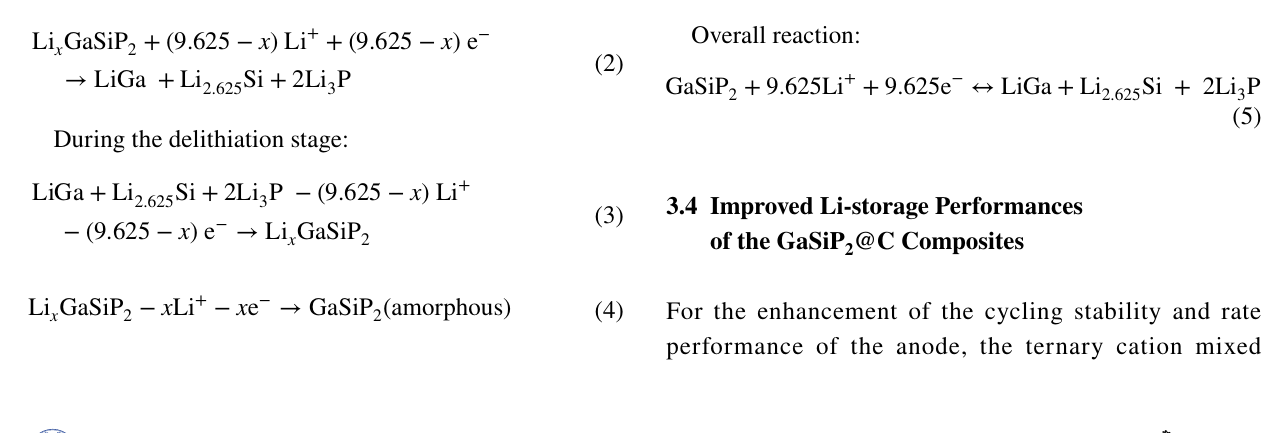
Fig. 7 a FESEM image and b low-magnification TEM image of the GaSiP 2 @C composite. c Raman spectrum of the pristine cation-mixed GaSiP 2 compound (the inset) and the GaSiP 2 @C composite; d High-resolution XPS spectra of P 2 p ; e – i Elemental mapping images; Capacity retentions j over 300 cycles at 200 mA g −1 and k over 900 cycles at 1,000 mA g −1 , respectively; l Rate performance; m Discharge and charge curves at different current